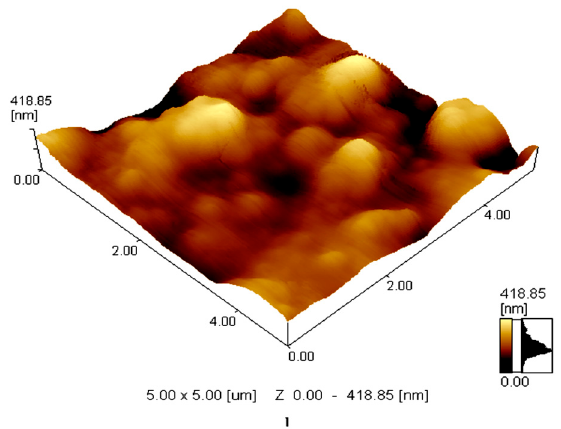
Figure 2. AFM image of the prepared membrane of the Optode 4 based on NOPE as a plasticizer.